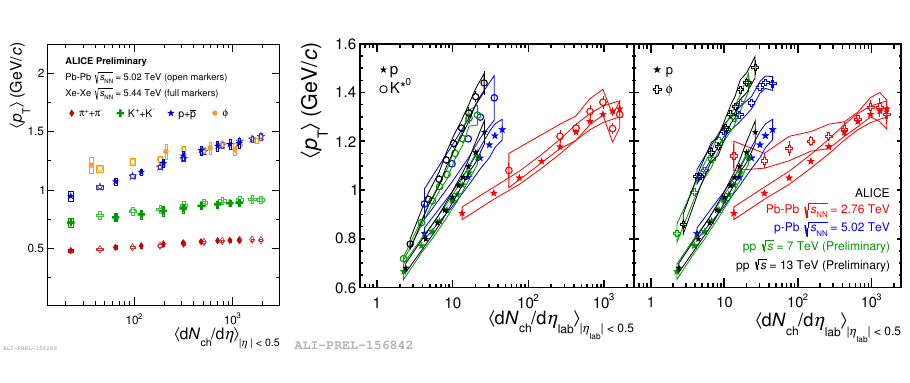
Figure 2. (color online) The mean transverse momentum as a function of the charged-particle multi- plicity density. (left) pion, kaon, proton and φ . (right) K ∗ 0 (left panel) and φ (right panel) compared to p (same data in both